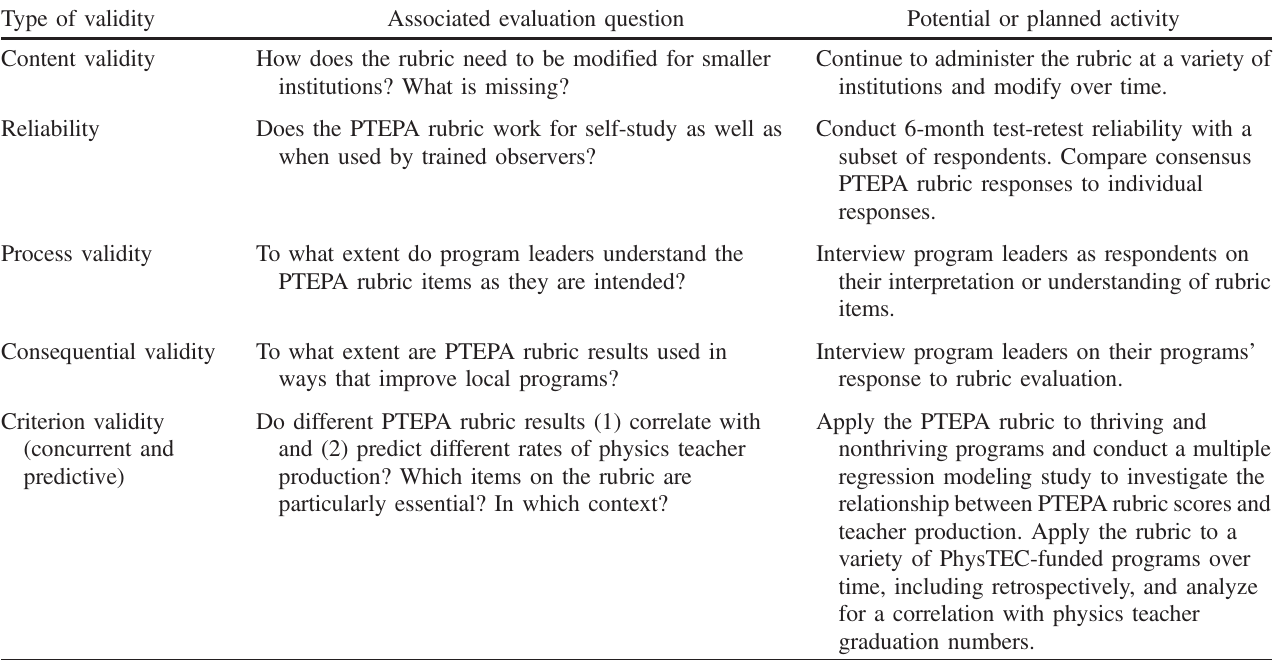
TABLE IV. Planned validation